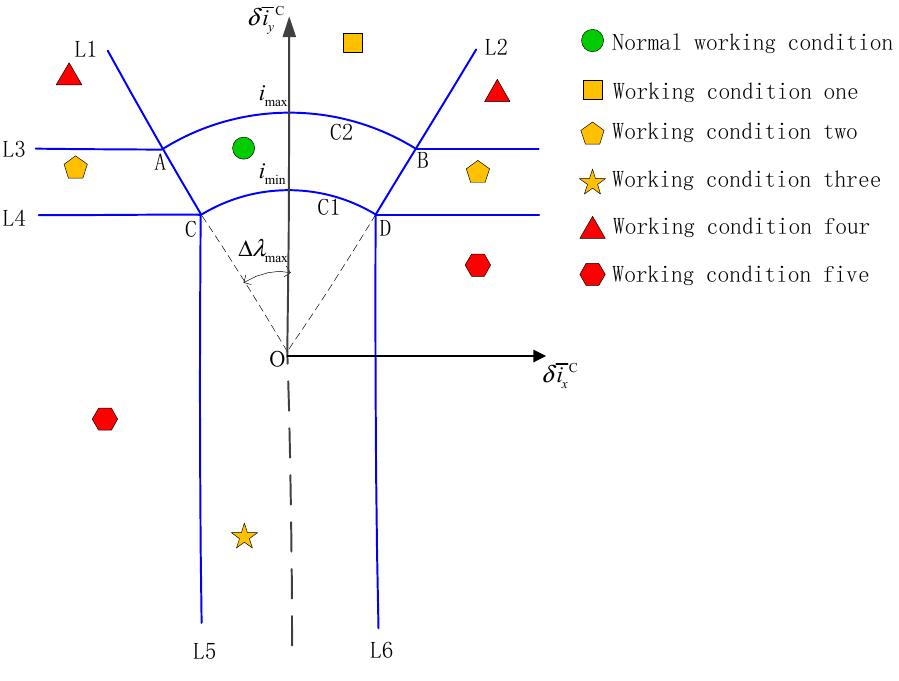
Figure 6. The NSSK Figure 6. The NSSK strategy.